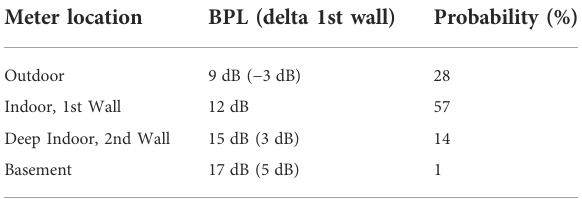
TABLE 2 Mean BPL based on measurements commissioned at BRE.